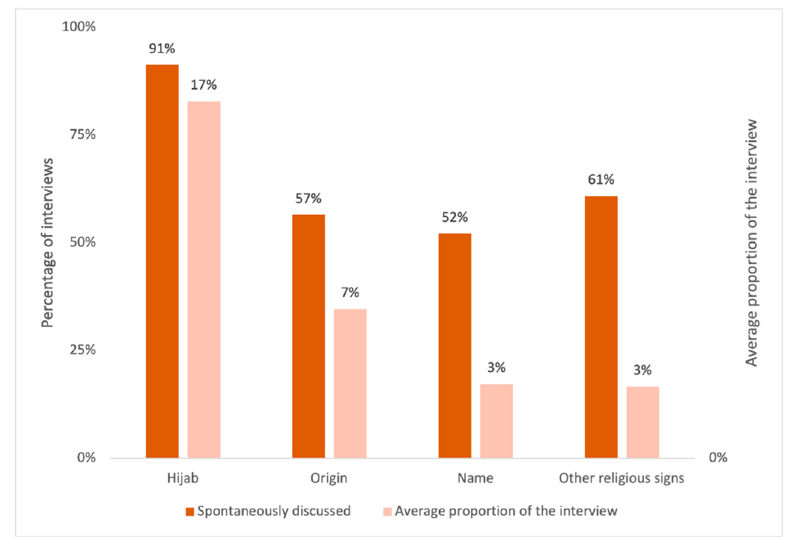
Figure 1. Spontaneity with which the experts raise an issue ( left ), and average proportion of the interview that they give to markers of Muslimness ( right